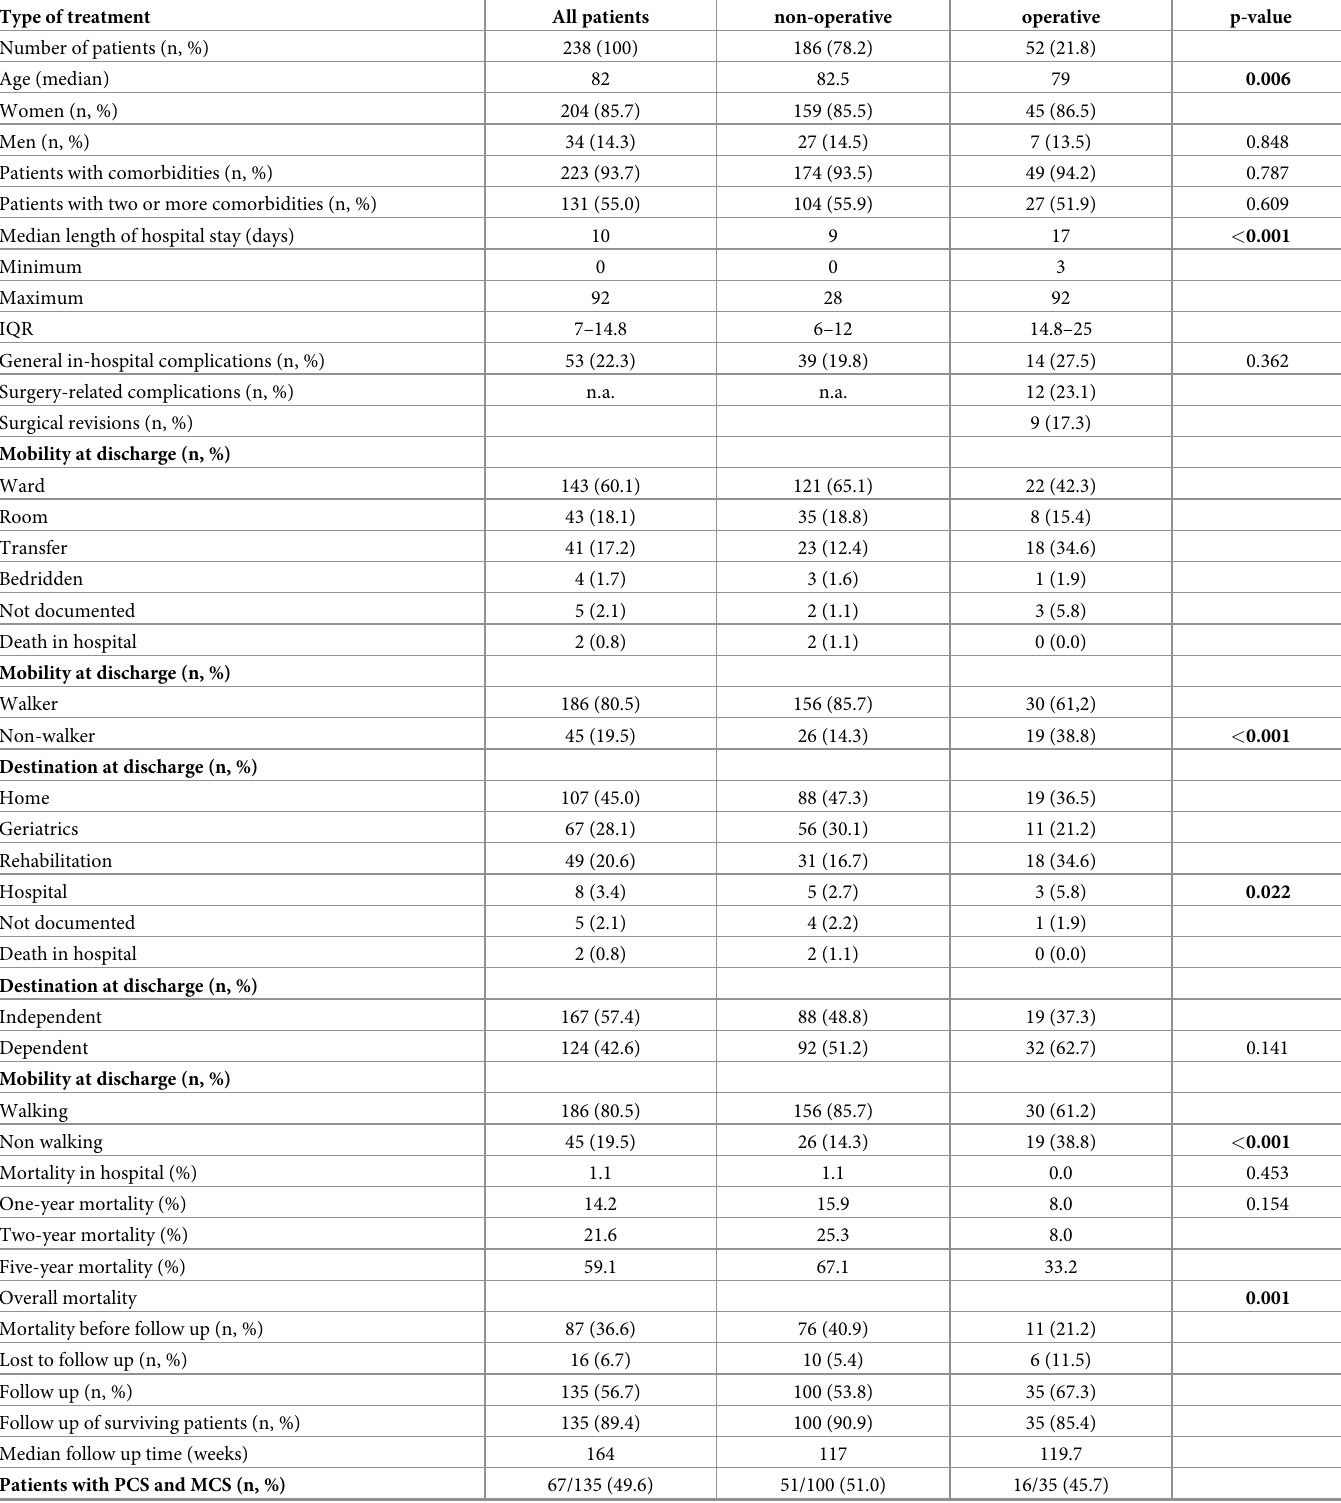
Table 6. Demographics, LoS, mortality, situation at discharge and at follow up of FFP type II patients, depending on type of